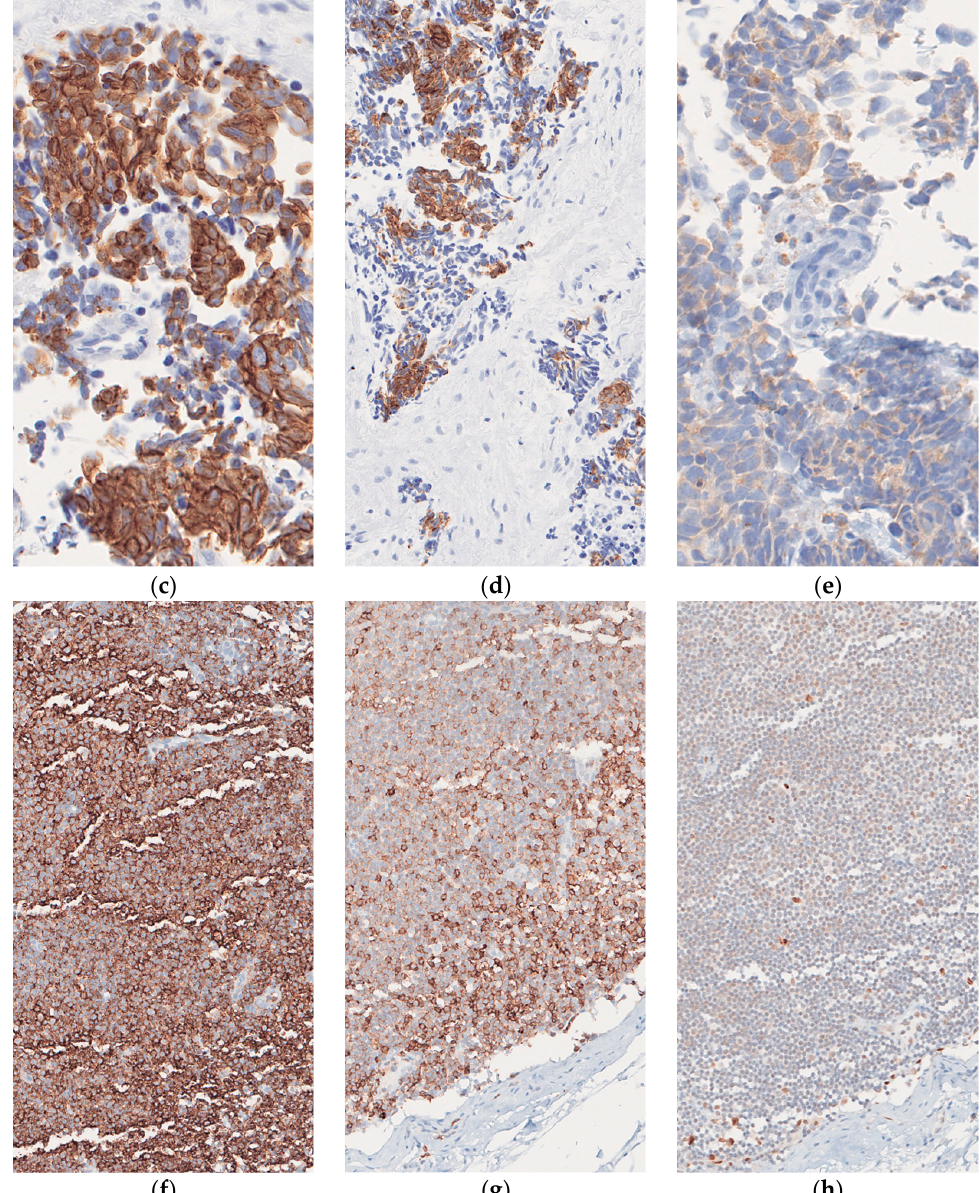
Figure 2. Case 2. ( a ) Left cheek and neck mass showing aggregates and cords of atypical basaloid cells with hyperchromatic nuclei and scant cytoplasm along with numerous mitotic figures and necrotic cells consistent with MCC. ( b ) Left posterior triangle lymph node showing broad effacement of architecture by a dense infiltrate of small monomorphous lymphocytes consistent with CLL. Note the adjacent subcapsular focus of metastatic MCC (Black arrow) (H&E; original magnification: ( a ) 20×; ( b ) 5×). Immunohistochemical stains of left cheek/neck mass ( c – e ) and left posterior triangle lymph node ( f – h ). ( c ) Low molecular weight keratin showing diffuse cytoplasmic staining of tumor cells (Magnification 40×). ( d ) CK20 showing cytoplasmic and focal dot-like staining in tumor cells (Magnification 20×). ( e ) Synaptophysin showing faint focal positivity in tumor cells (Magnification 40×). ( f ). CD20 diffusely highlights atypical B lymphocytes (Magnification 20×). ( g ) CD5 showing aberrant staining of neoplastic B lymphocytes (Magnification 20×). ( h ) Cyclin-D1 is negative in neoplastic B lymphocytes (Magnification 20×).